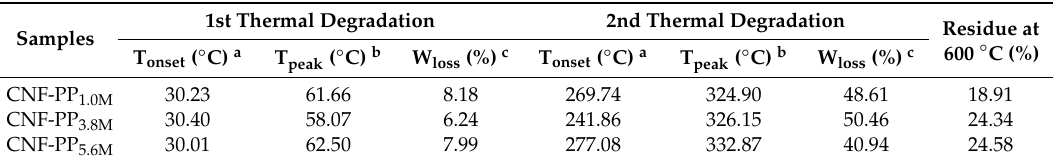
Figure 6. DTG curves of CNF-PP 1.0M , CNF-PP 3.8M and CNF-PP 5.6M . Table4. ThermalparametersofCNF-PP 1.0M ,CNF-PP 3.8M andCNF-PP 5.6M obtainedfromthermogravimetric analysis (TGA) and derivative thermogravimetric (DTG)